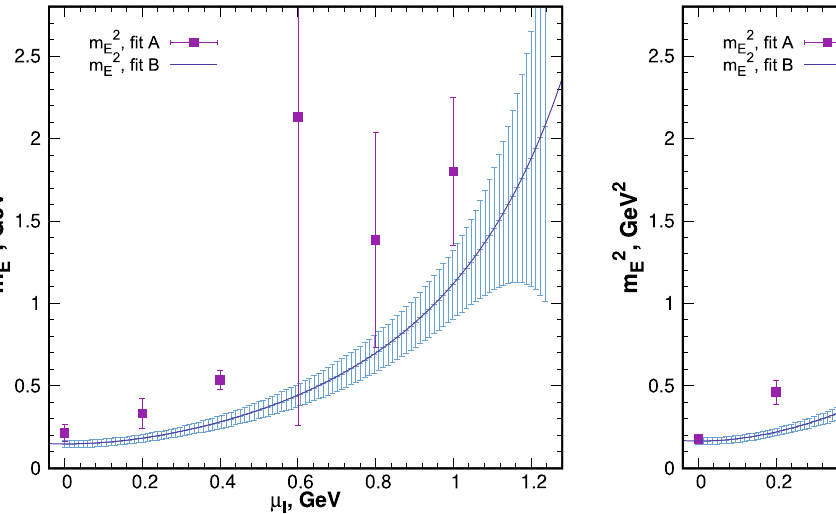
Fig. 2 The chromoelectric squared screening masses as a function of the isospin chemical potential. Fit A is related to the fit functions (15); fit B – to (20); the momentum ranges are 0 ≤ p < 1 . 5 GeV (left) and